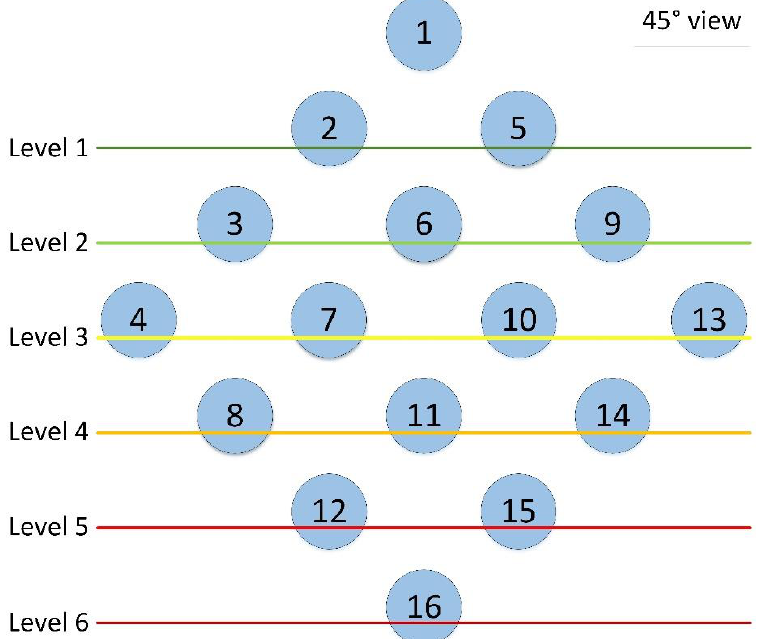
Table 3 . The power consumption for the different slot types.